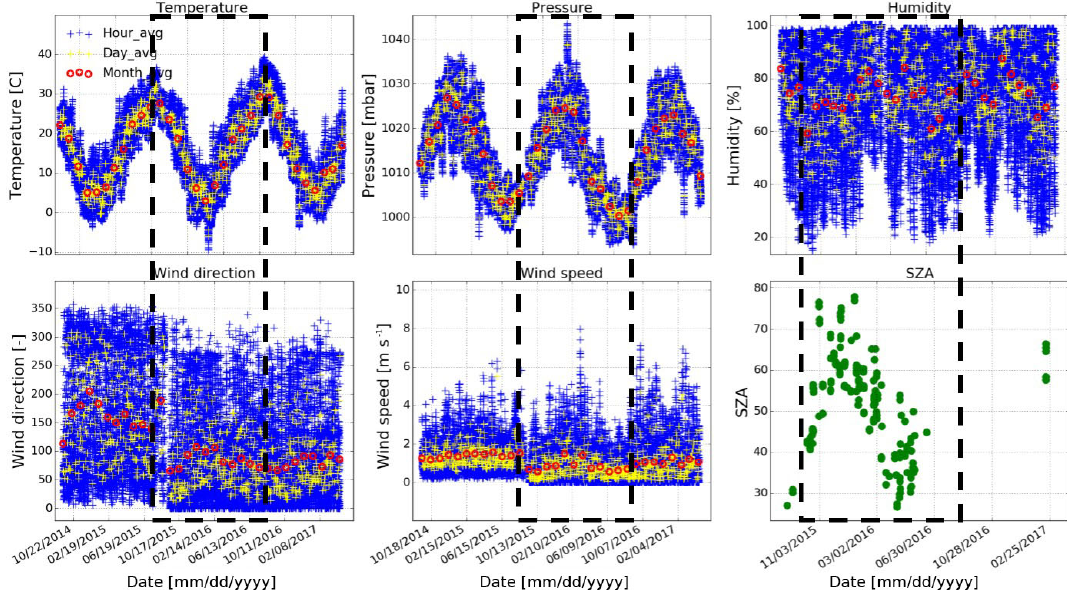
Figure 19. The meteorological data and SZA record at Hefei. Large span of all these parameters is shown for the period from August 2015 to August 2016 (black dotted